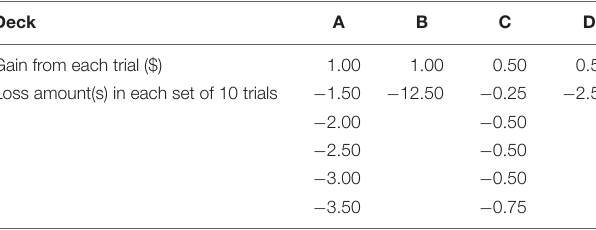
TABLE 1 | Payoff distribution of the Iowa Gambling